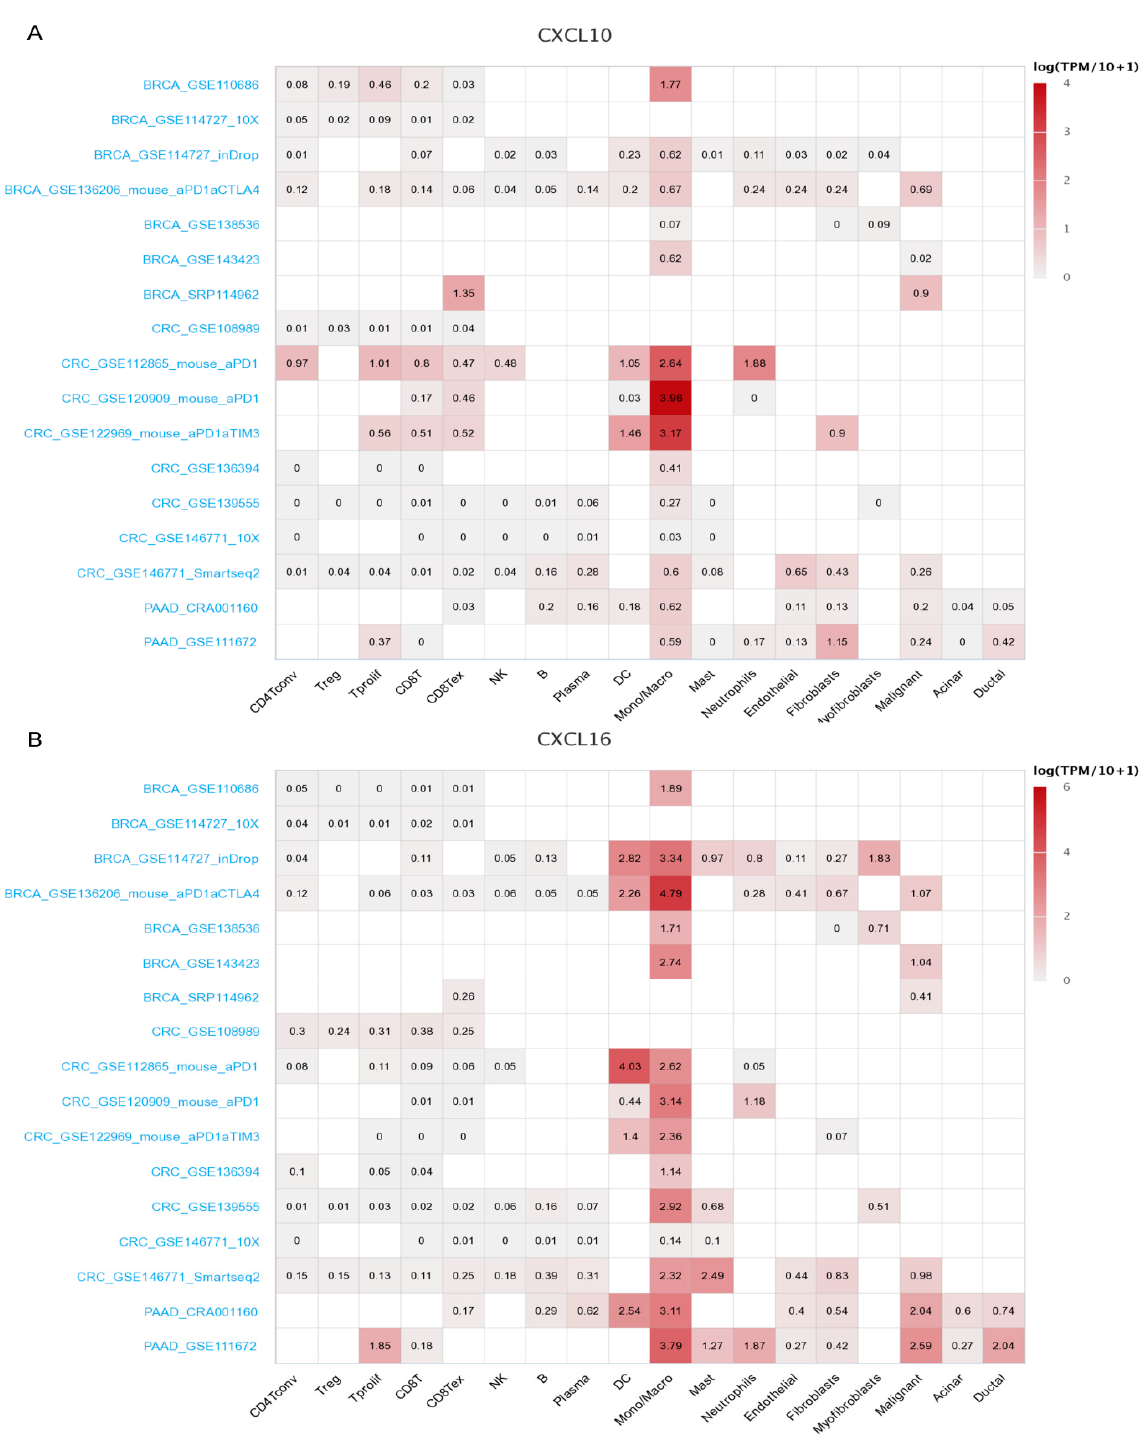
Figure 3. Expression levels of CXCL10 and 16 analysis by using TISCH in cell subpopulations of BRCA, COAD, and PDAC. Heatmap of CXCL10 ( A ) and 16 ( B ) expression in different cell subpopulations.